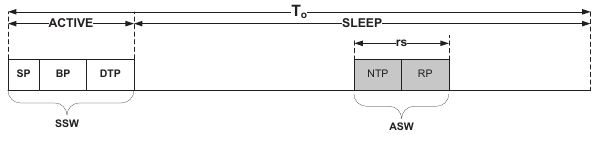
Figure 4. Asynchronous scheduled